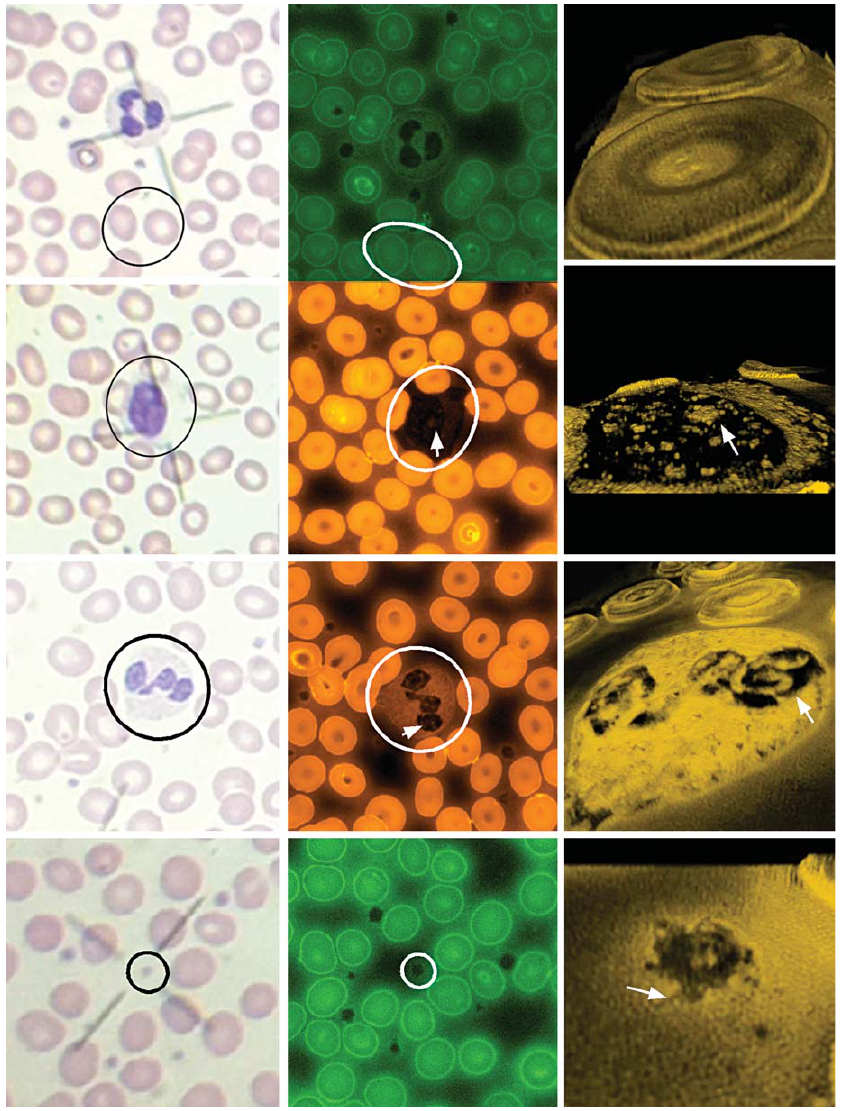
Fig. 2. Comparison of transmitted light (left column), fluorescence (middle column) and SIM (right column) images of red blood cells (top row), a monocyte cell (second row from the top), a neutrophil cell (third row from the top) and a platelet (bottom row). Note, the color in fluorescence images and in SIM images are pseudo-colors for rendering, not related to the color of the real fluorescence. The cells of interest are enclosed by circles, arrows point to features that are not well discerned in fluorescence images but in SIM